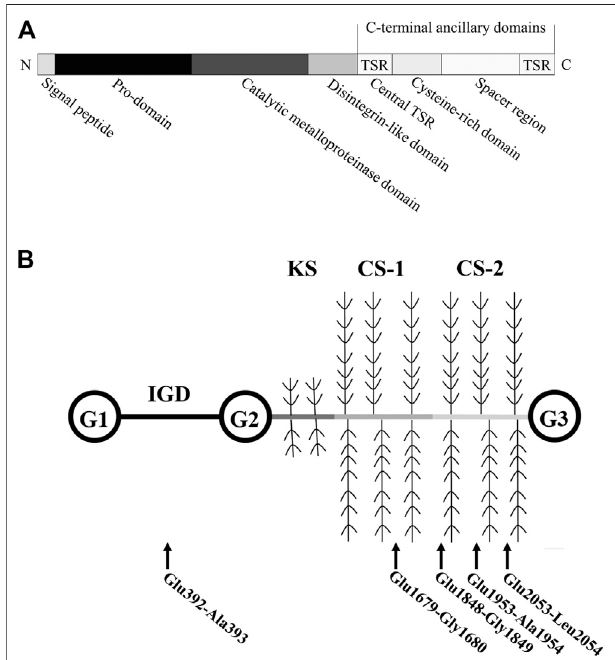
FIGURE 1 | Structure of human ADAMTS5 and Aggrecan. (A) Human ADAMTS5 domain structure. Thrombospondin type 1 sequence repeat, central TSR. (B) Structure of Aggrecan. ADAMTS5-mediated cleavage within the aggrecan occurs at (glutamate) Glu-Xaa (where Xaa (cid:1) alanine, glycine, and leucine) recognition motifs. Abbreviations: globular domains, G1-3; interglobular domain, IGD; keratan sulfate attachment domain, KS; chondroitin sulfate attachment domains, CS-1 and